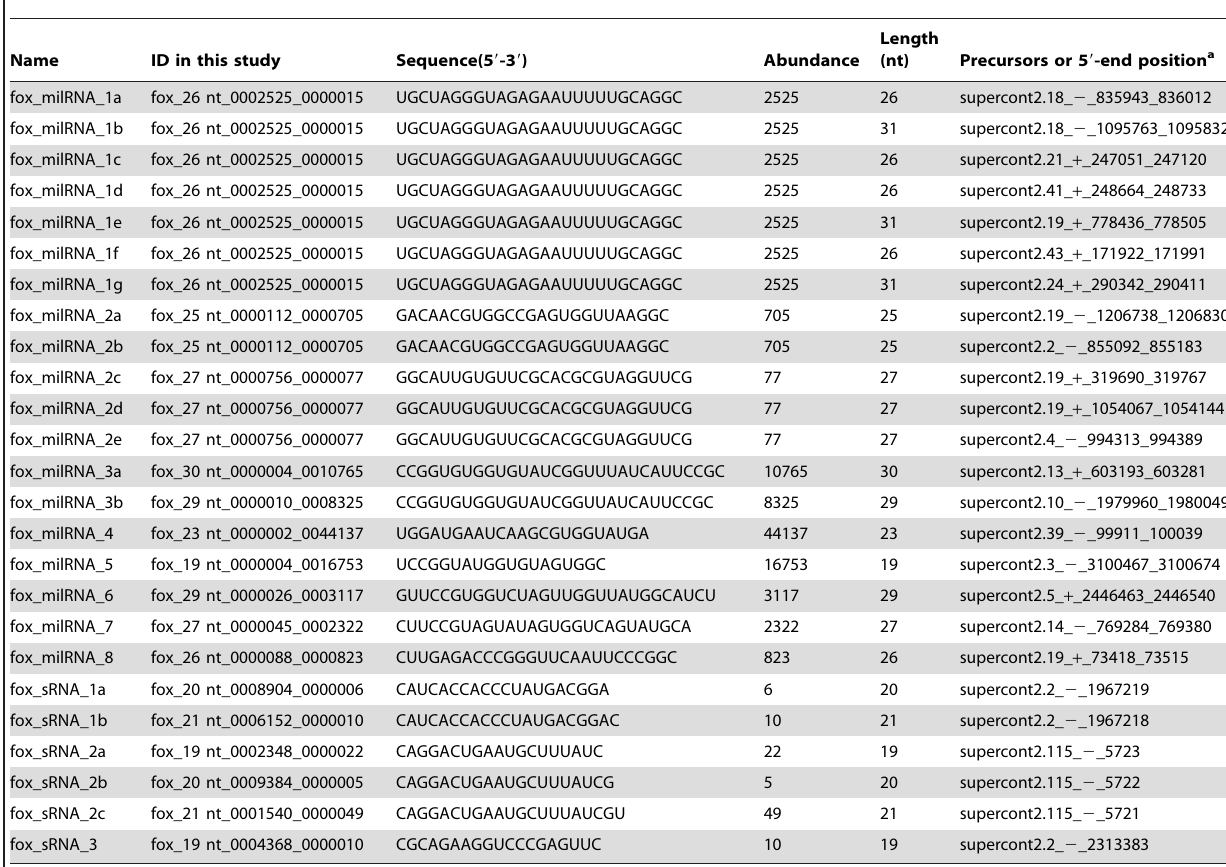
Table 2. milRNAs of F. oxysporum identified in this